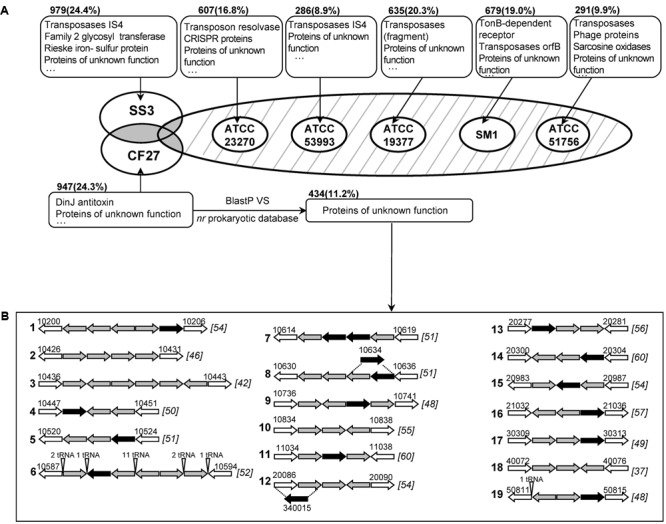
(A)Venn diagram of orthologous groups (OG) from seven Acidithiobacillus genomes. Only strain-specific genes are displayed. The strain names are: CF27, At. ferrivorans CF27; SS3, At. ferrivorans SS3; ATCC 23270, At. ferrooxidans ATCC 23270T; ATCC 53993, At. ferrooxidans ATCC 53993; ATCC 19377, At. thiooxidans ATCC 19377T; SM1, At. caldus SM-1; and ATCC 51756, At. caldus ATCC 51756T. The main functional proteins are shown in boxes. The number of strain-specific genes is shown with the percentage (compared to the corresponding proteome) in the parentheses. Common genes between Acidithiobacillus species (shaded in gray or with hatching lines) are described in Supplementary Figure S4. (B) Gene organization of specific clusters in At. ferrivorans CF27. Specific gene clusters are limited by non-specific genes (in white arrows) with their locus names indicated above. Successful specific gene expression obtained by RT-PCR is shown as black arrow. Clusters are numbered according to their location along the At. ferrivorans CF27 genome. The G + C content (%) of the overall gene cluster is shown in brackets.